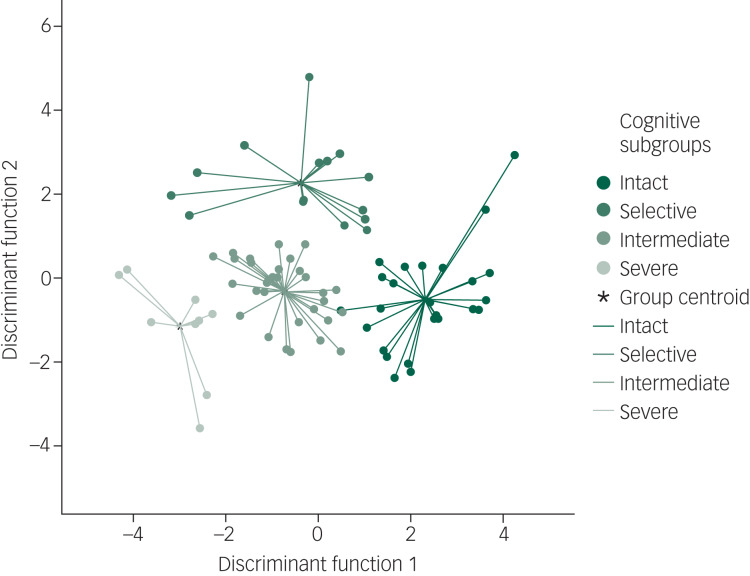
Graphical agglomeration of the cognitive subgroups (cognitively intact; selective deficit in verbal learning and memory; intermediate impairment across all domains; and severe global impairments). Data plots represent participant scattering and clustering based on the discriminant function values. Group centroids represent mean scores for each cluster.